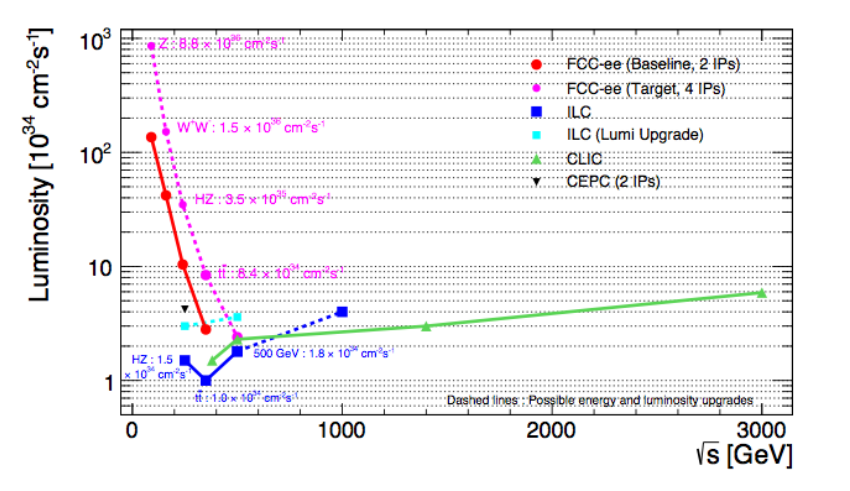
Figure 2. The luminosity expected at TLEP (full red line), with four interactions points, the luminosities expected at linear colliders, ILC (blue line) and CLIC (green